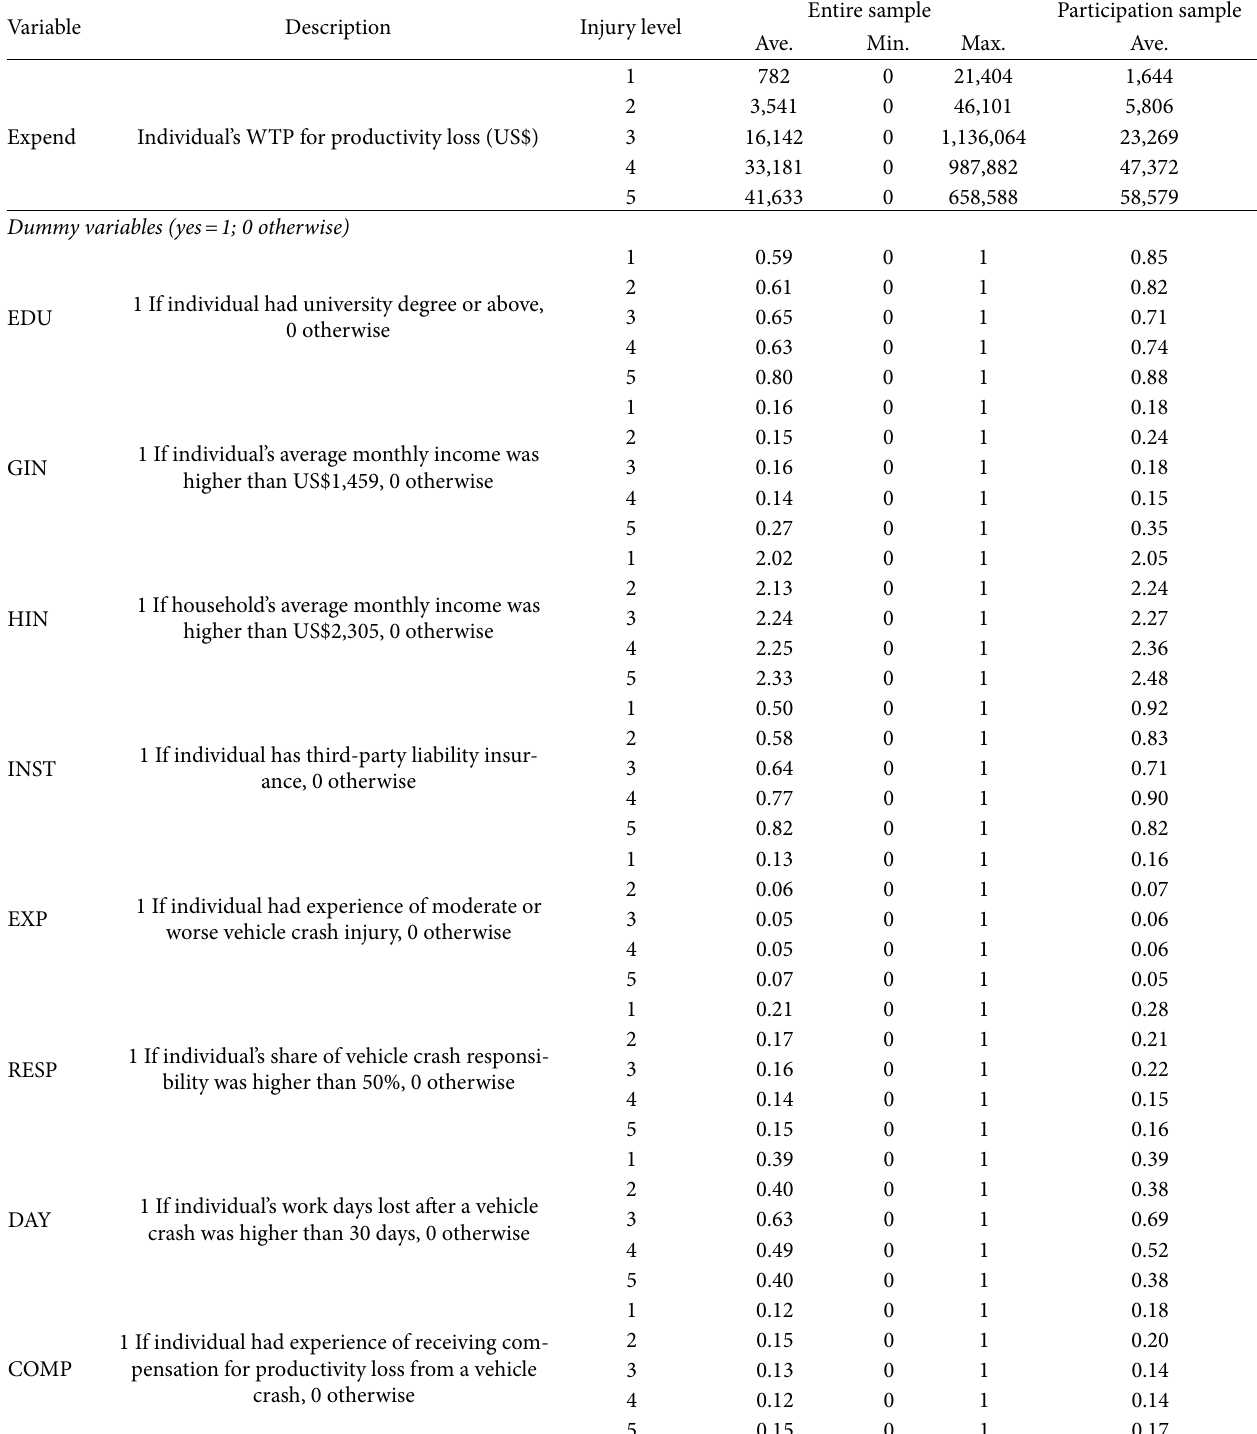
Table 3: Summary